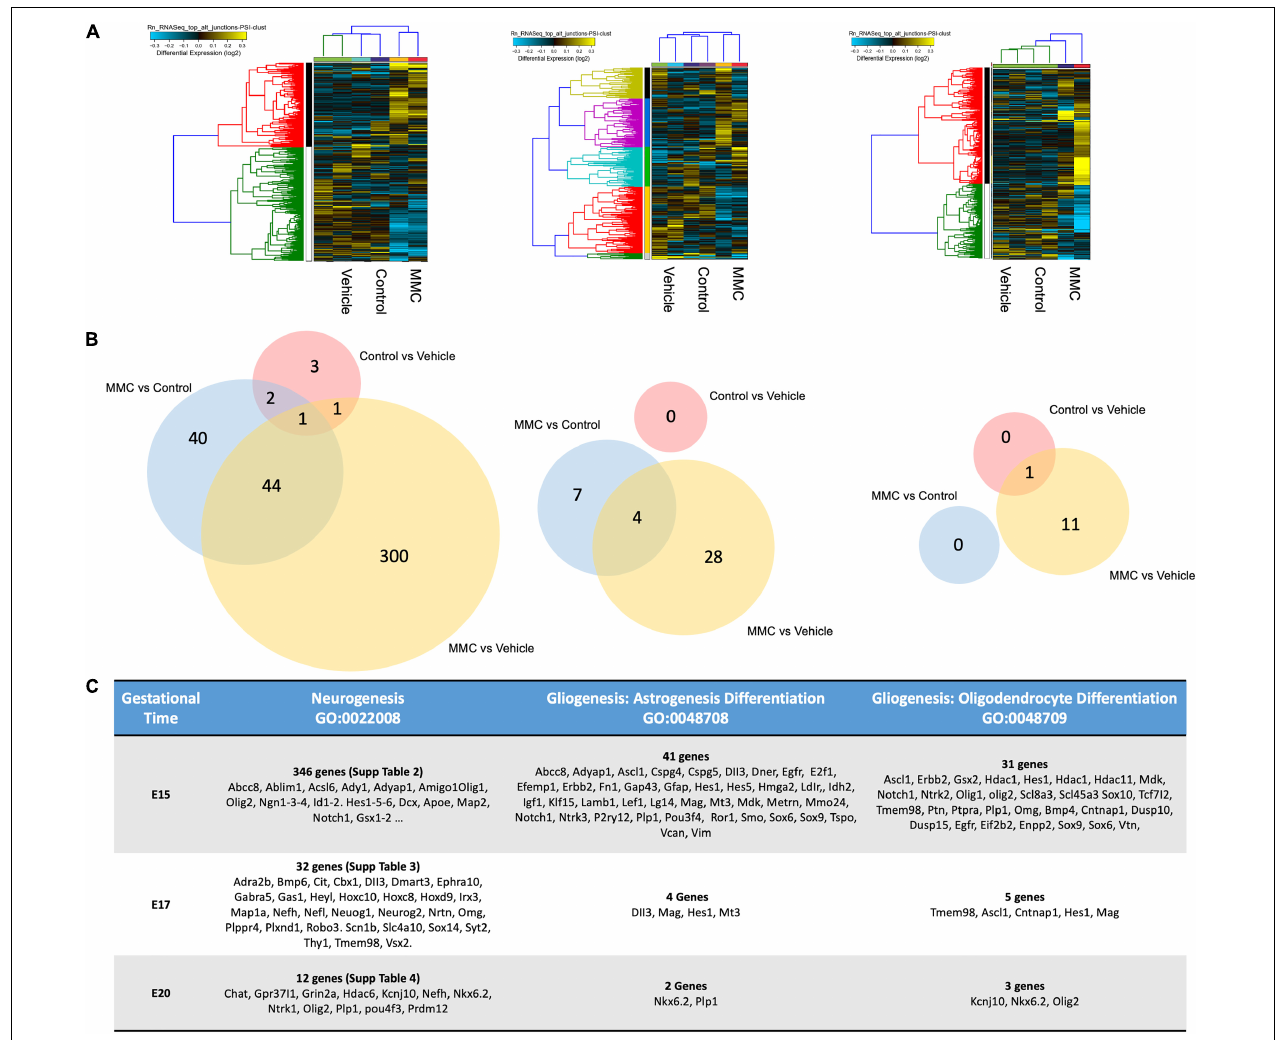
FIGURE 5 | Cluster analysis of differentially expressed genes. (A) Hierarchical cluster analysis of differentially expressed genes showed transcriptome-wide expression patterns similar between the control and vehicle groups compared to MMC samples in all three gestational ages E15, E17, and E20 days. (B) Venn diagram of the DEGs in different comparisons. The numbers indicate unique and common DEGs in two duplicates for different comparisons MMC vs. VC, MMC vs. NC and NC vs. VC. (C) Analysis of two sub-classifications within the Neurogenesis GO, Oligodendrocyte Differentiation (GO:0048709), and Astrocyte Differentiation (GO:0048708) DEGs between the control and vehicle groups compared to MMC at E15, E17, and E20 days.